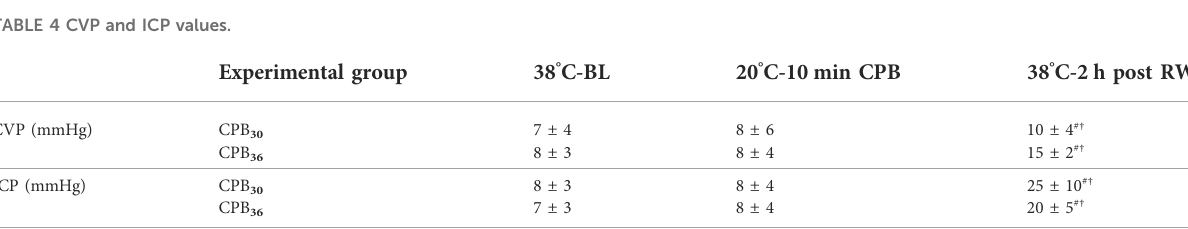
TABLE 4 CVP and ICP